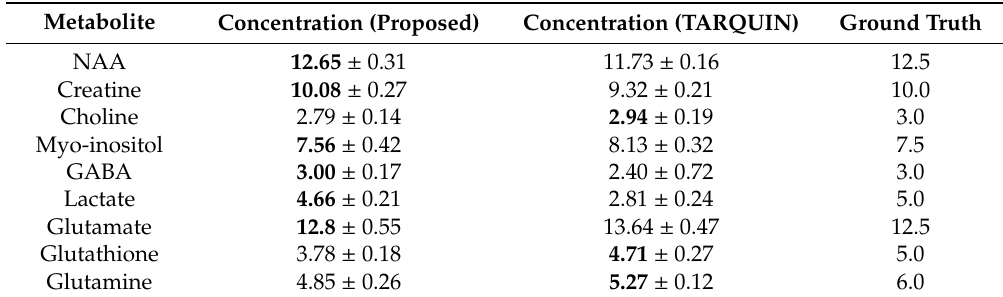
Table 3. Mean and 95% confidence interval of the phantom’s metabolite concentration quantified by the proposed approach and the